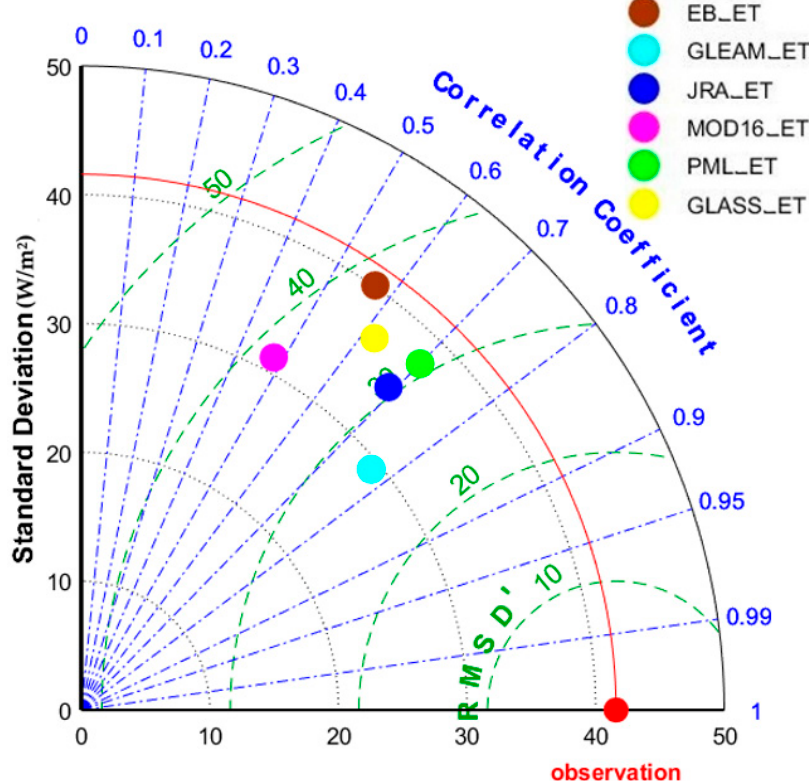
Figure 5. The results of the ET validation conducted using the EC observations shown as a Taylor diagram. The units of the STD and RMSD’ values are W/m 2 .